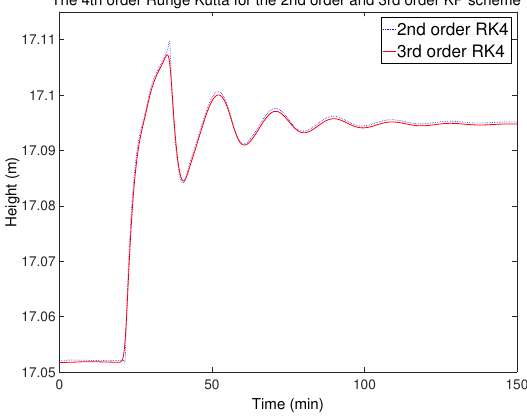
Figure 6: The RK4 method for 2 nd and 3 rd order KP scheme ( (cid:52) t = 0 . 25 s ).